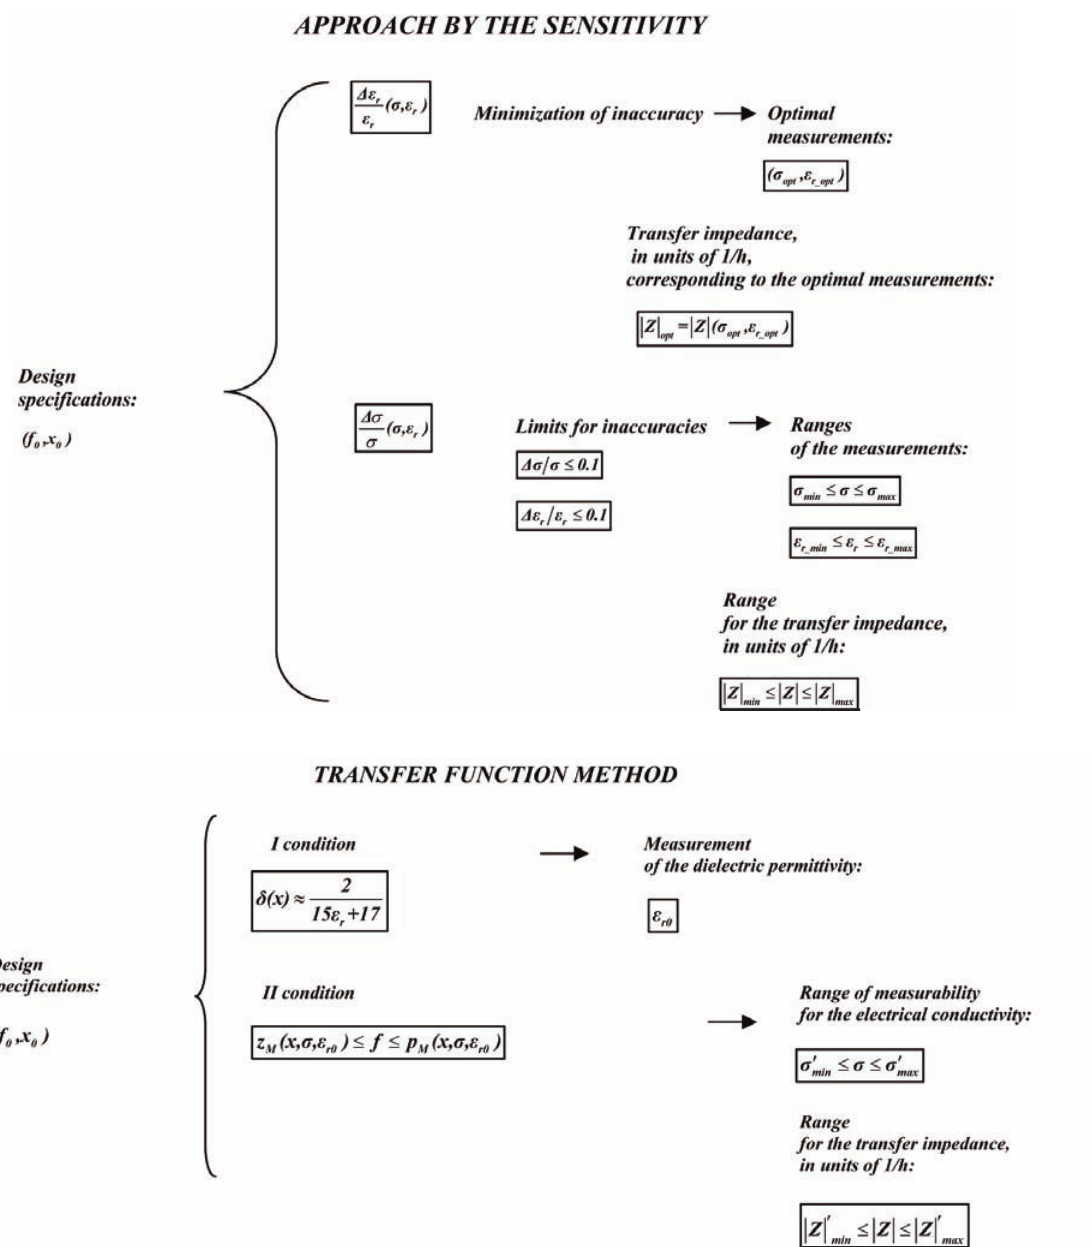
Figure 7. Conceptual schemes for numerical simulations to establish the measurable ranges of electrical conductivity and dielectric permittivity, limiting inaccuracies in the measurements of the quadrupole probe in capacitive contact, and fixing its optimum working frequencies and characteristic geometrical dimensions [ D | Z |/| Z |= DU / U = 10 −3 Z Z